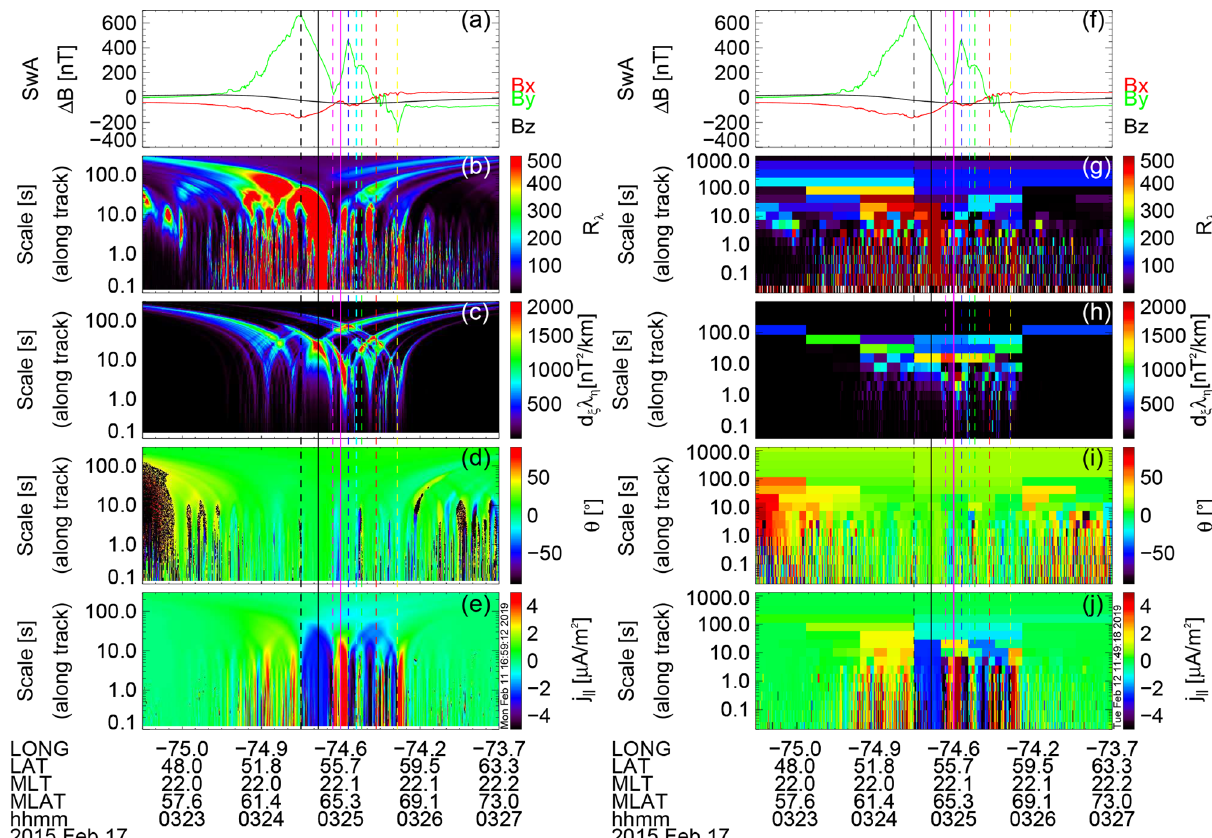
Figure 5. MSMVA analysis for the linear (left) and logarithmic (right) schemes. (a) Magnetic field perturbation; (b) planarity R λ ; (c) FAC location and characteristic scale ∂ ξ λ η ; (d) orientation; (e) multiscale FAC density; (f) – (j) show the same quantities for the logarithmic-scale sampling. MSMVA parameters represented as a function of the along-track scale. The vertical dashed lines delimit FAC segments as shown in Fig. 4. The vertical solid lines indicate the times for which we show the sections in Fig. 6.